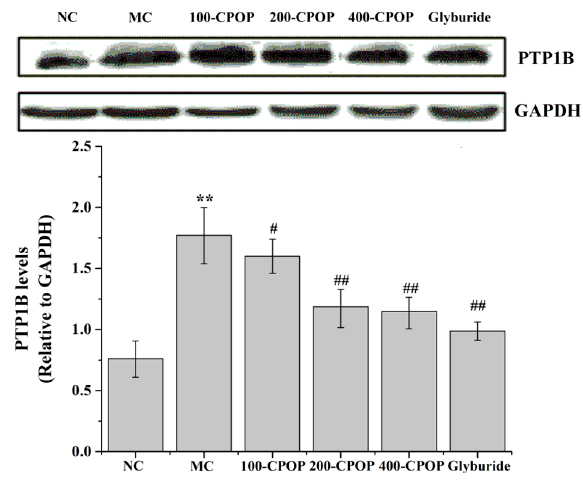
Figure 10. Effects of CPOP on protein tyrosine phosphatase 1B (PTP1B) levels in liver tissues of STZ-induced diabetic rats. ** p < 0.01 vs. NC group ( N = 8); # p < 0.05, ## p < 0.01 vs. MC group ( N = 8). NC is the normal control group; MC is the model control group; 100-CPOP is the 100 mg/kg per body weight CPOP group; 200-CPOP is the 200 mg/kg per body weight CPOP group; 400-CPOP is the 400 mg/kg per body weight CPOP group. GAPDH: glyceraldehyde-3-phosphate dehydrogenase.